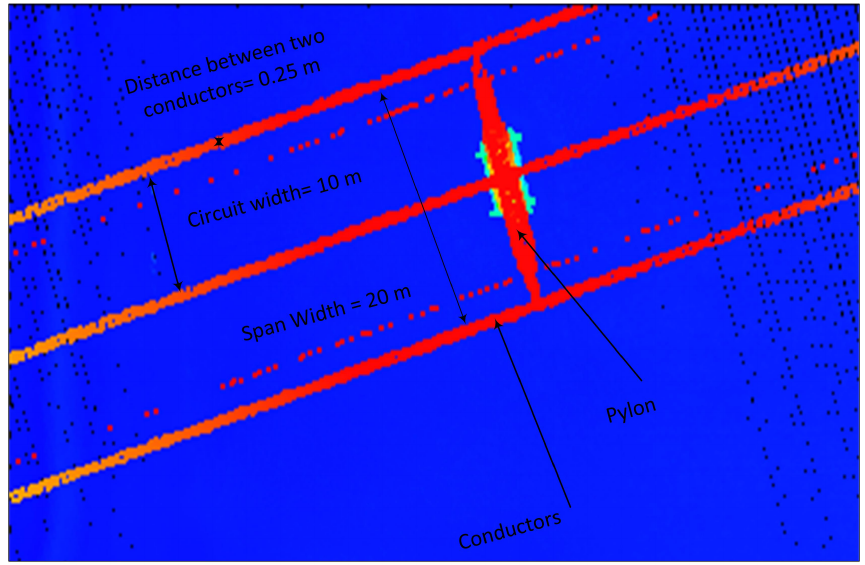
Figure 9. Power line infrastructure